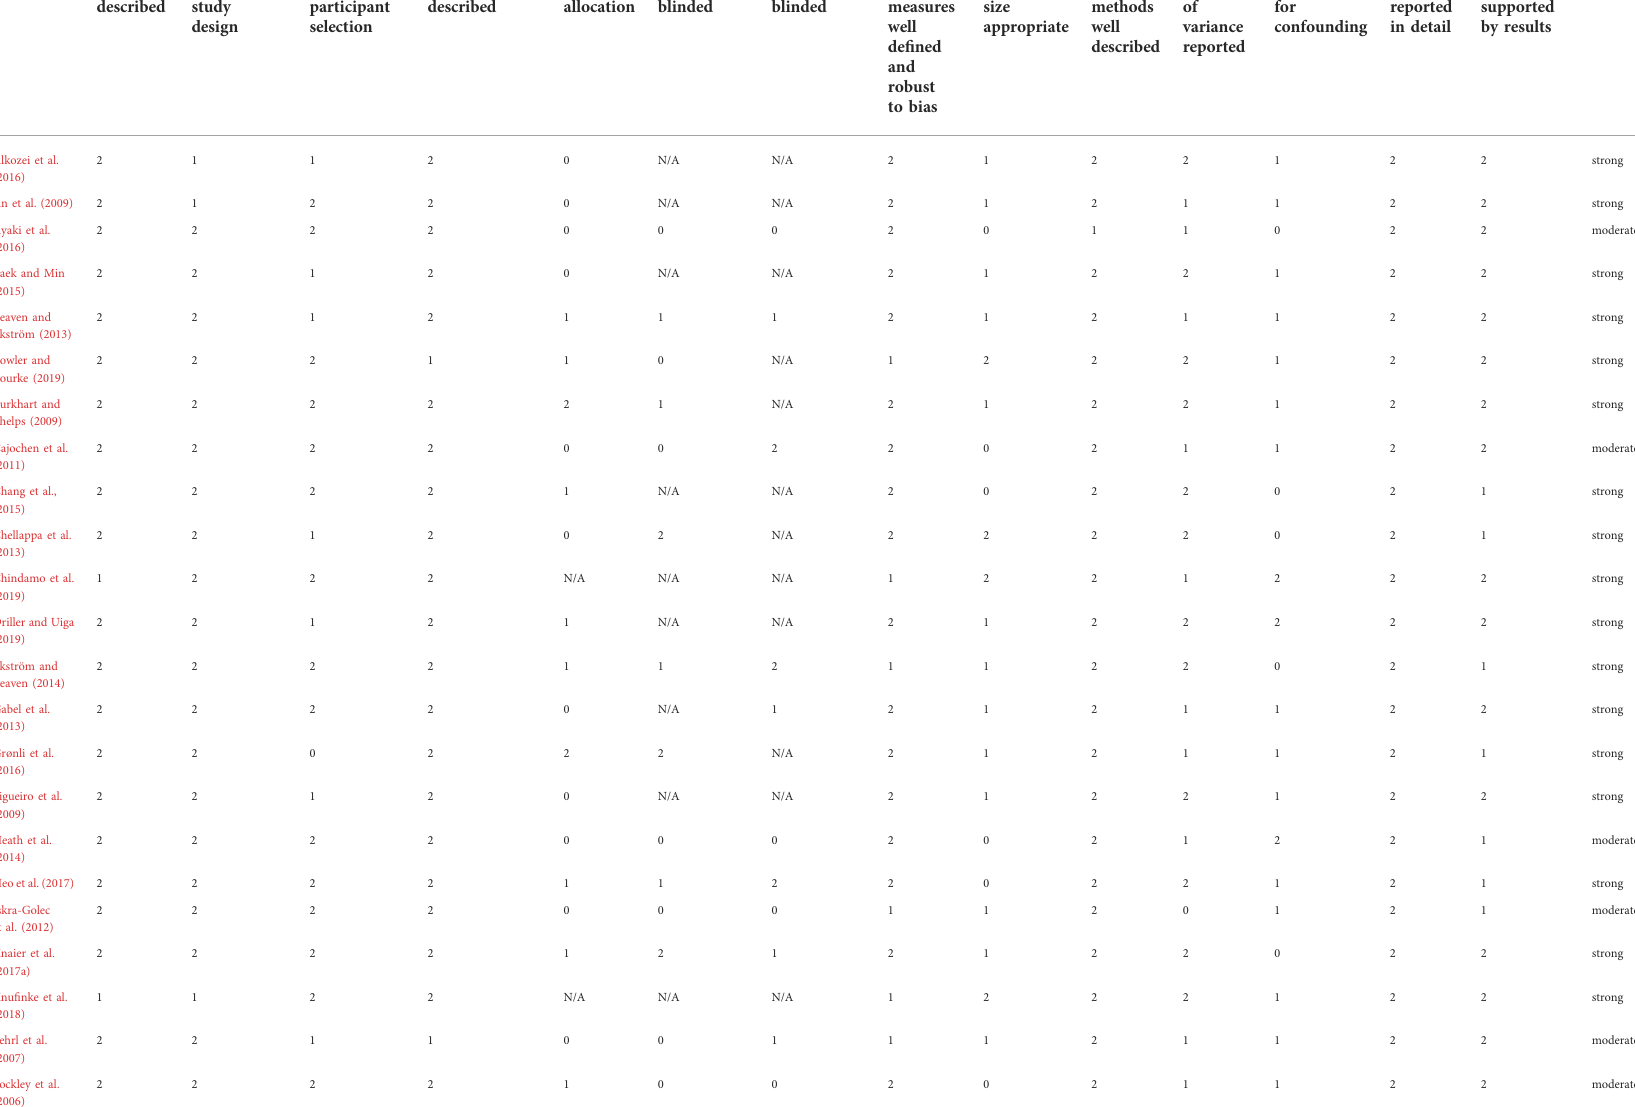
TABLE 2 Quality assessment “ QualSyst ” according to Kmet et al.